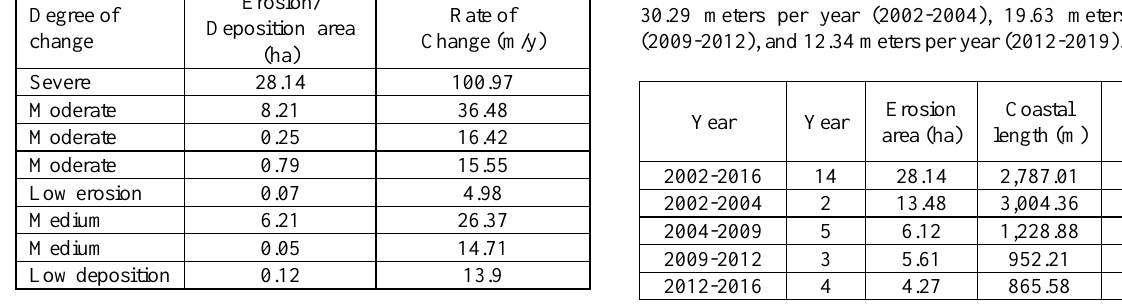
Table 6. The coastal changes at lower part of island between 2002 and